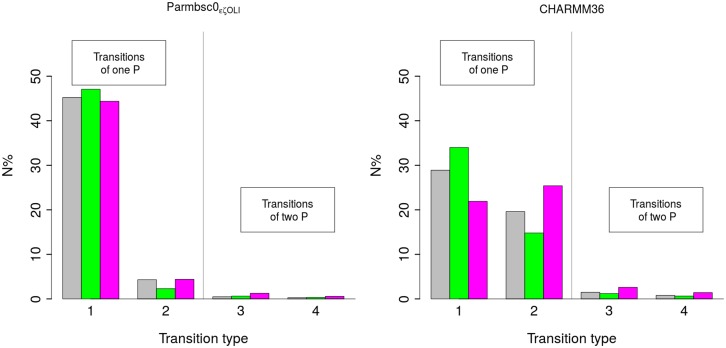
Statistics on the transitions between the conformational states of facing phosphate groups.The transitions between facing phosphate group combinations were analyzed for C5pG6•C19pG20 (grey) and T7pA8•T17pA18 (green) in Oligo 4, and C10pC11•G14pG15 (pink) in Oligo 2, from P-MDs (left) and C-MDs (right). These steps were chosen because they adopt BII•BII in the simulations. N% is the percentage of a transition type relative to the total number of transitions. The transition types are labeled as follow: 1: BI•BI → BI•BII|BII•BI or the inverse, BI•BII|BII•BI → BI•BI; 2: BI•BII|BII•BI → BII•BII or BII•BII → BI•BII|BII•BI; 3: BI•BII → BII•BI or BII•BI → BI•BII; 4: BI•BI → BII•BII or BII•BII → BI•BI.